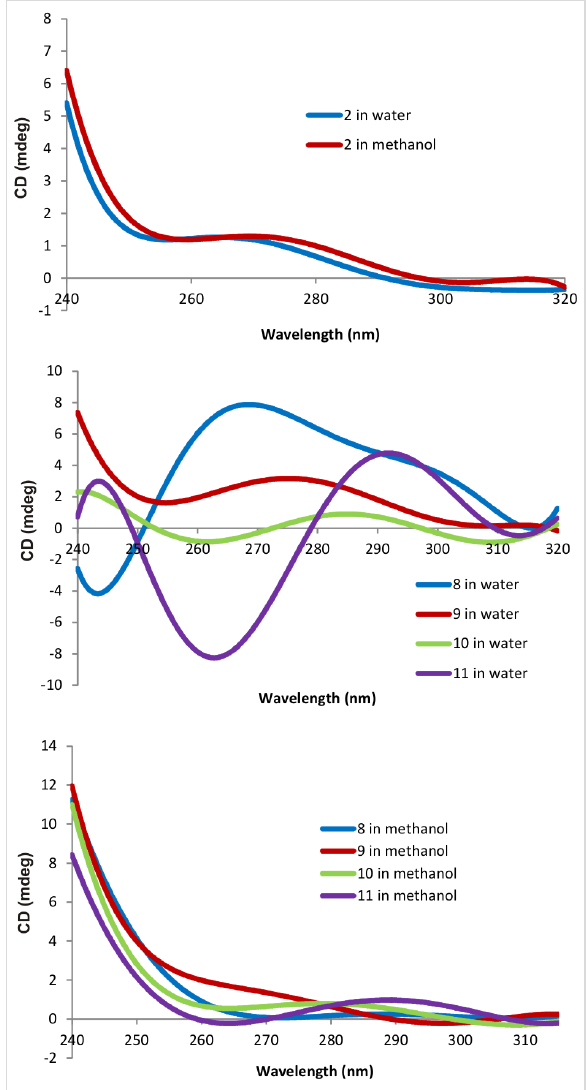
Figure 5: The CD spectra of the compounds 2 and 8 – 11 in water and methanol.